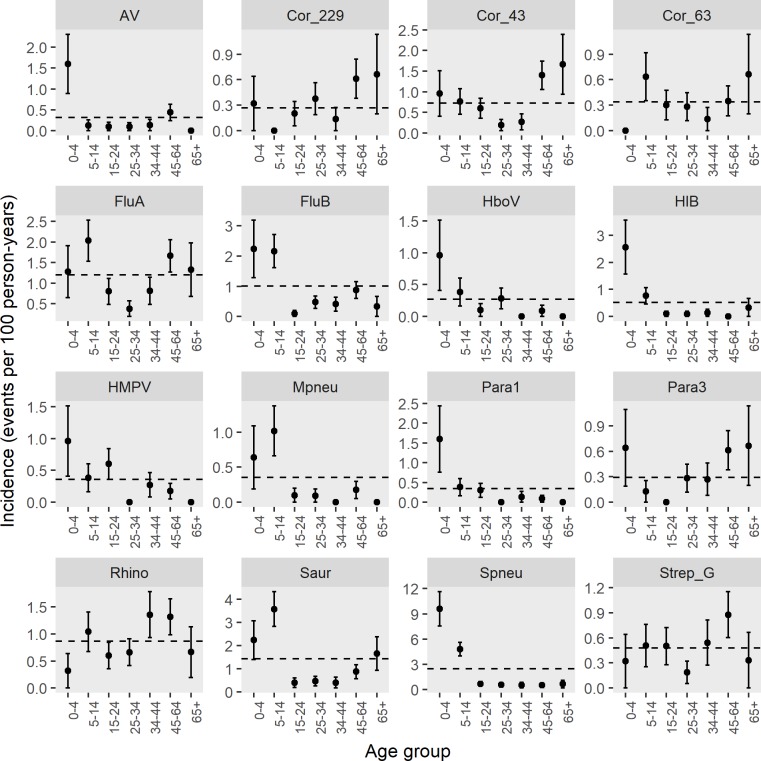
Incidence of the most commonly detected pathogens by age-group.Error bars represent -/+ standard errors. Dashed horizontal lines represent the age and sex adjusted estimate for the overall Vientiane capital population.